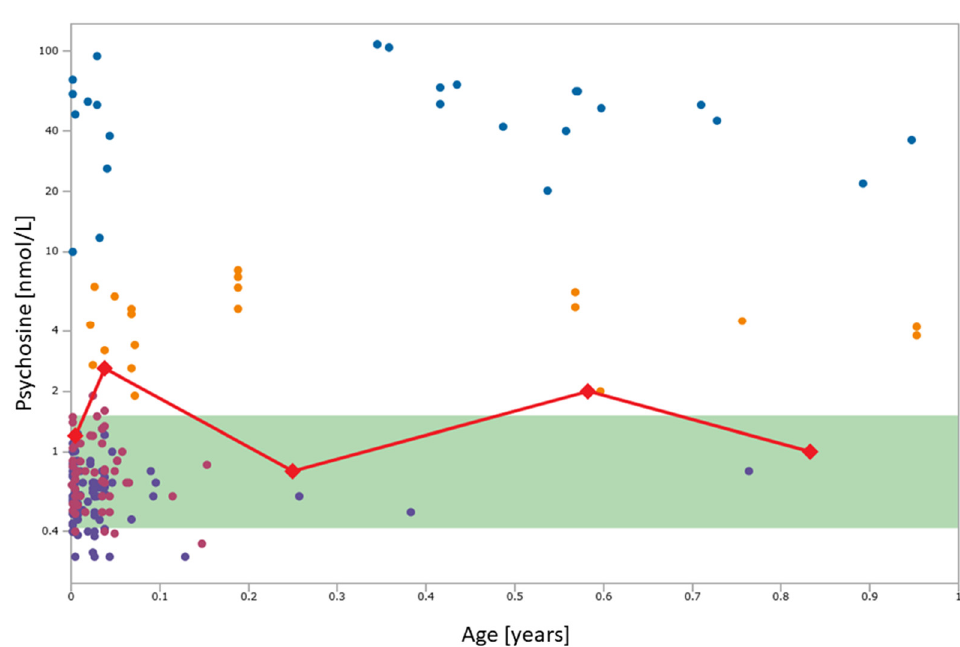
Figure 1. Psychosine concentrations in dried blood spots collected at 2 days old for newborn screening, and at 2 weeks, 3 months, 7 months, and 10 months of age in comparison to the control range (green band), cases with infantile onset Krabbe disease (blue circles; n = 25), later onset Krabbe disease variants (orange circles; n = 20), GALC mutation carriers (magenta circles; n = 50), and individuals with GALC activity lowering genotypes (“pseudodeficiency”; purple circles; n = 97). Figure created in Collaborative Laboratory Integrated Reports (https://clir.mayo/edu, accessed on 23 April 2021); Psychosine values are shown on a log scale.